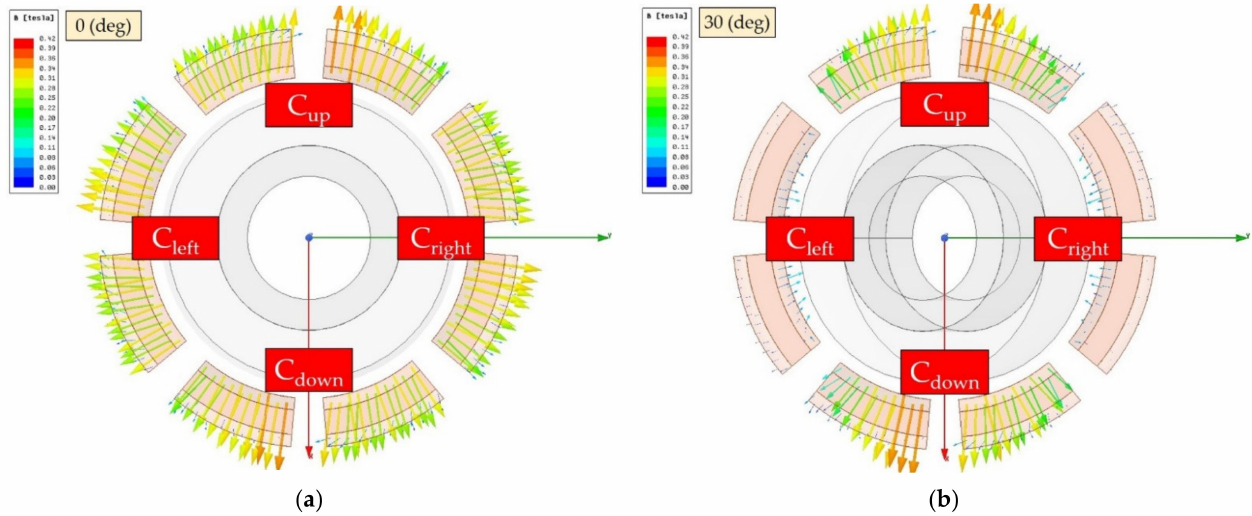
Figure 9. The magnetic field distribution for the rotation about the Z -axis when the rotor is tilted at ( a ) 0 ◦ and ( b ) 30 ◦ along the X